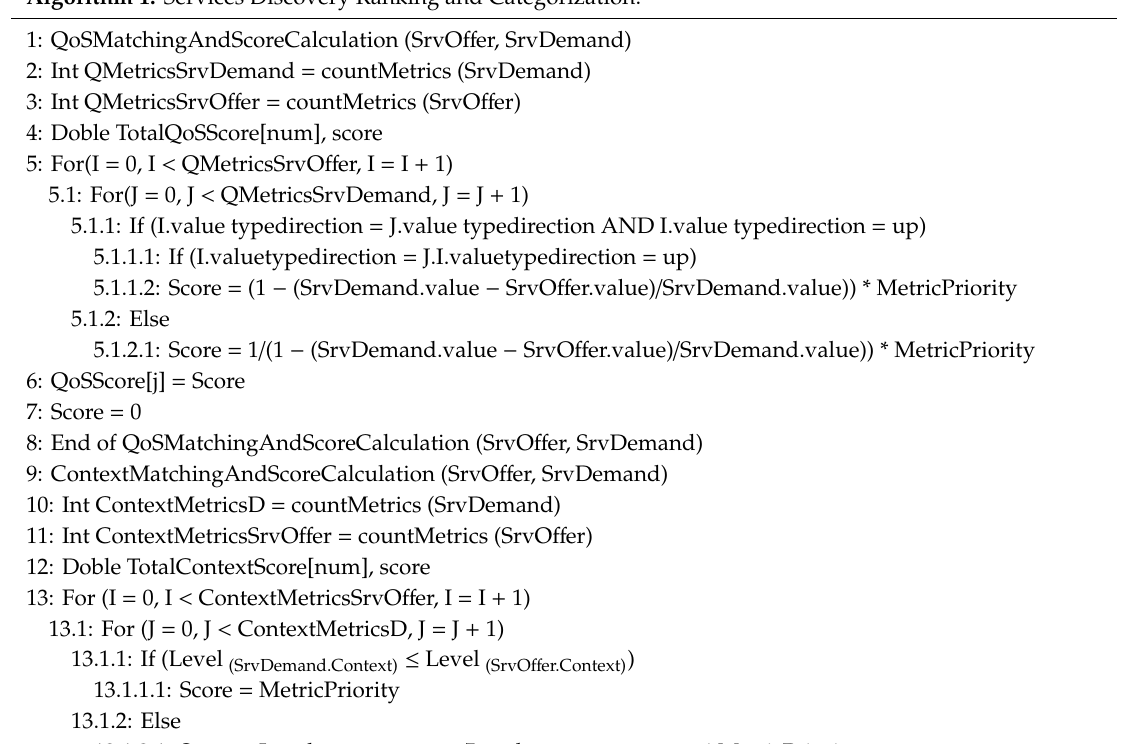
Algorithm 1. Services Discovery Ranking and